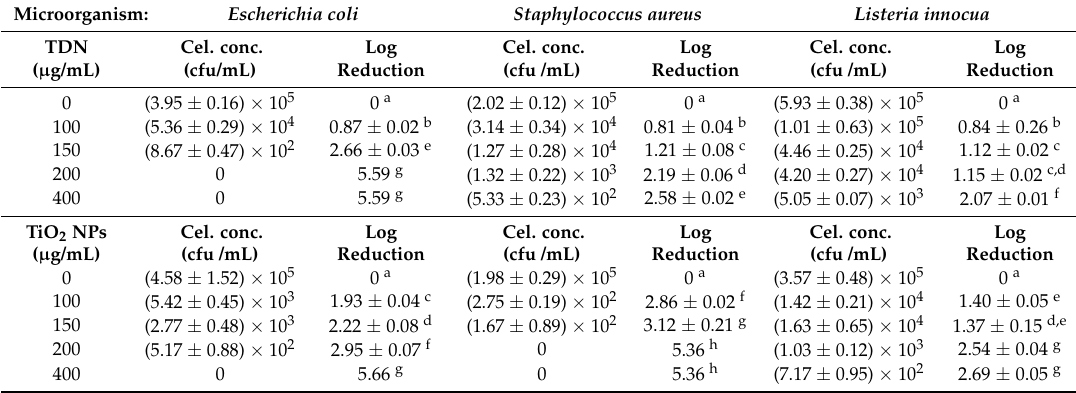
Table 2. Antimicrobial results of TDN and commercial TiO 2 NPs at different concentrations against different